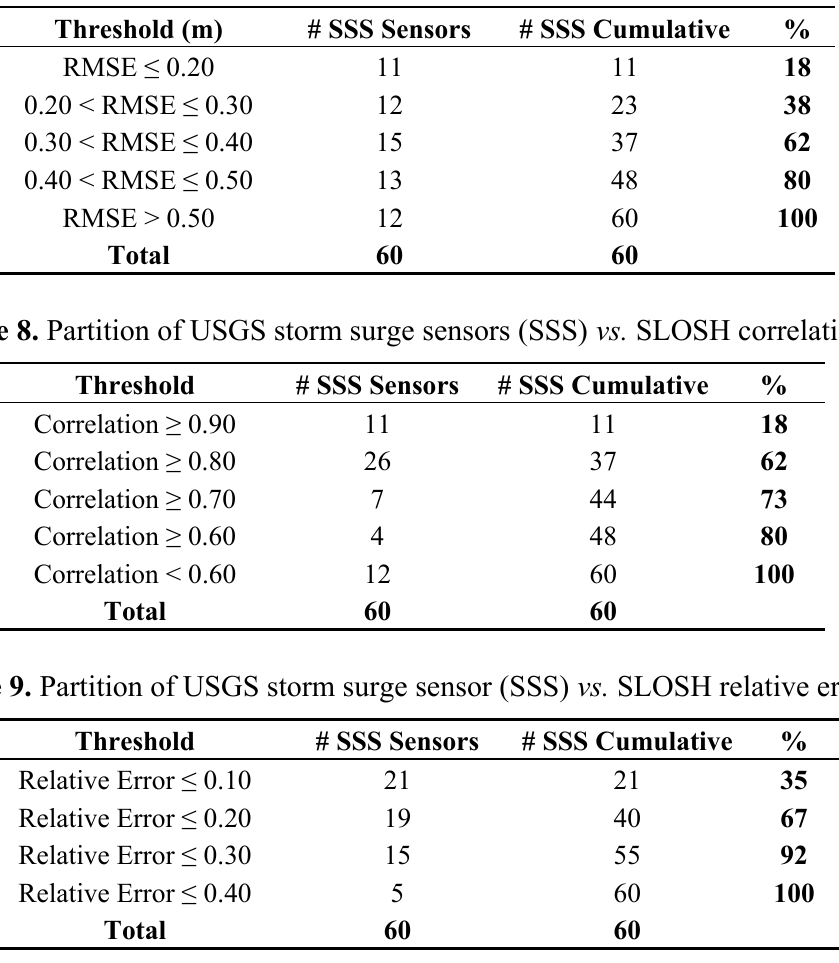
Table 7. Partition of USGS storm surge sensors (SSS) vs. SLOSH root mean square errors (m).